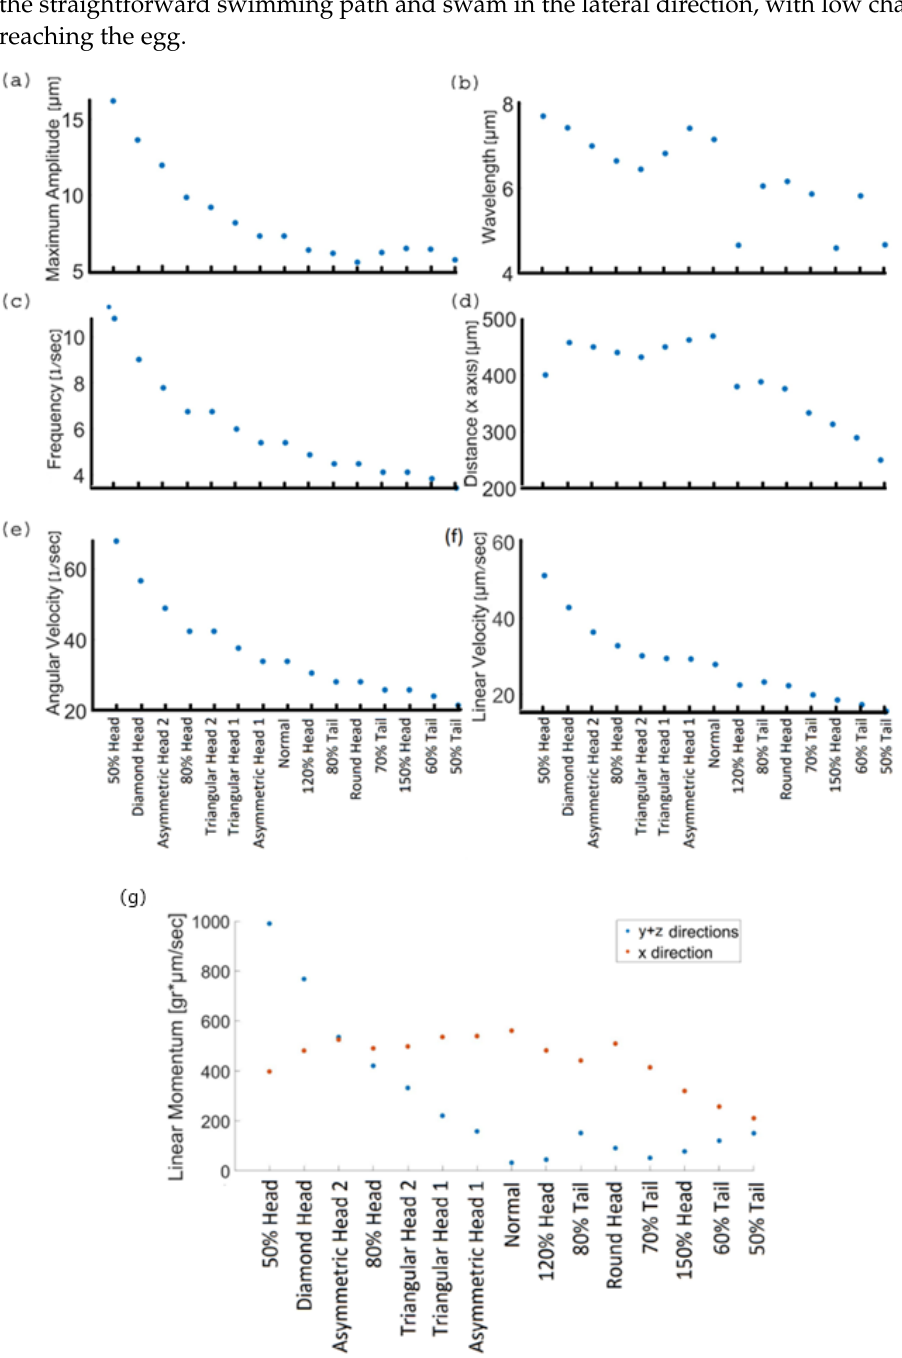
Figure 7. Kinetic parameters of 3D swimming patterns. Maximum amplitude ( a ), wavelength ( b ), frequency ( c ), distance ( d ), angular velocity ( e ), linear velocity, and ( f ) linear momentum values in the forward direction ‘ x ’ (red) and the lateral direction ‘ y + z ’ (blue) ( g ) of the different sperm models swimming in saline